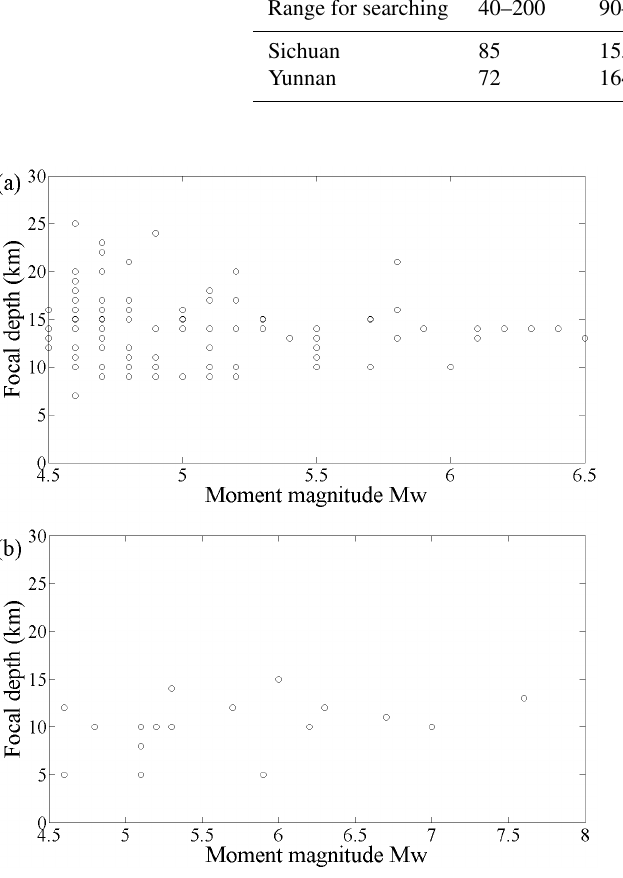
Figure 5. M w hypocentral distance distribution of strong ground motion records in (a) the Sichuan region and (b) the Yunnan